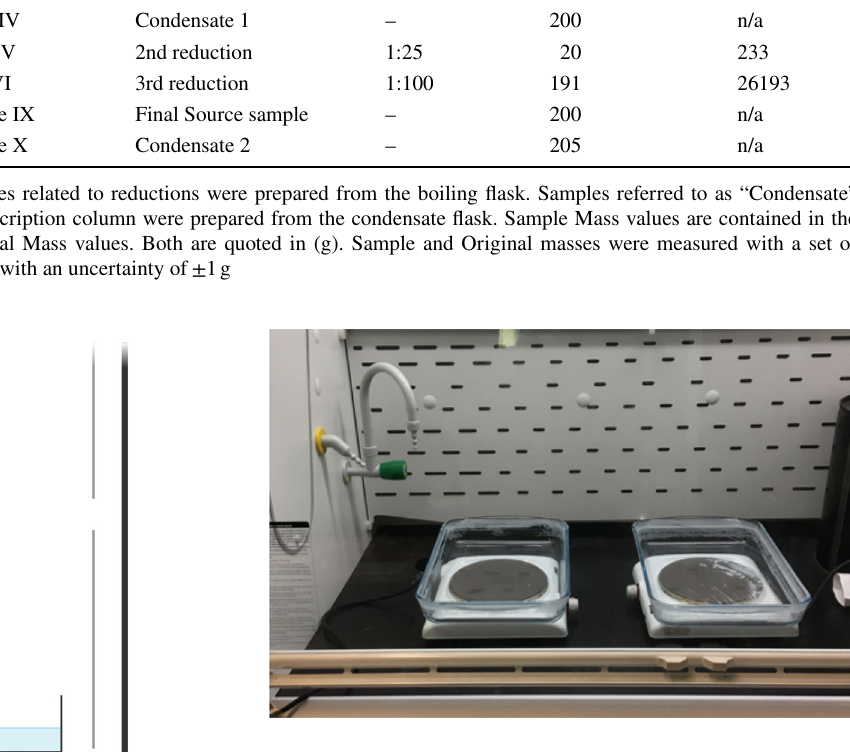
Fig. 4 Photographs of two Pyrex® trays positioned on top of two electric hobs to achieve the open system